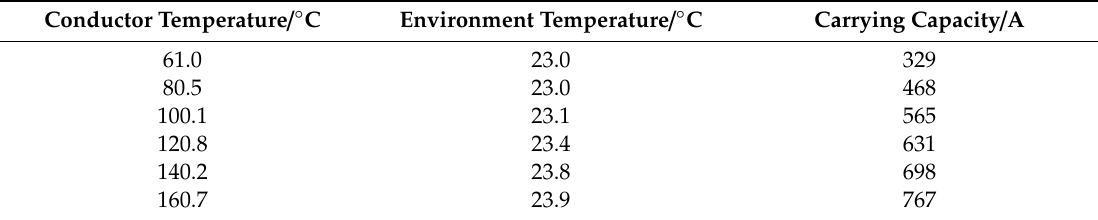
Carrying capacity test results under the conditions of no wind, no sunshine, and natural convection.